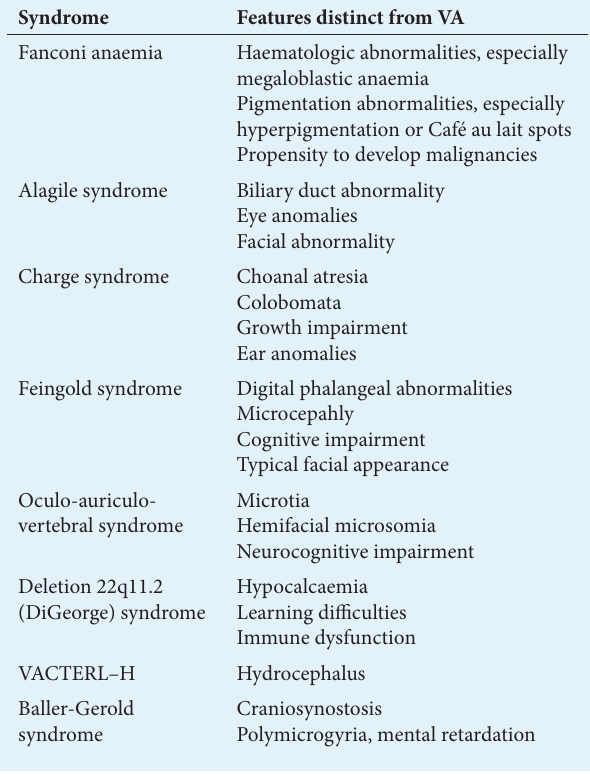
Table 2. Key features distinguishing the main differential